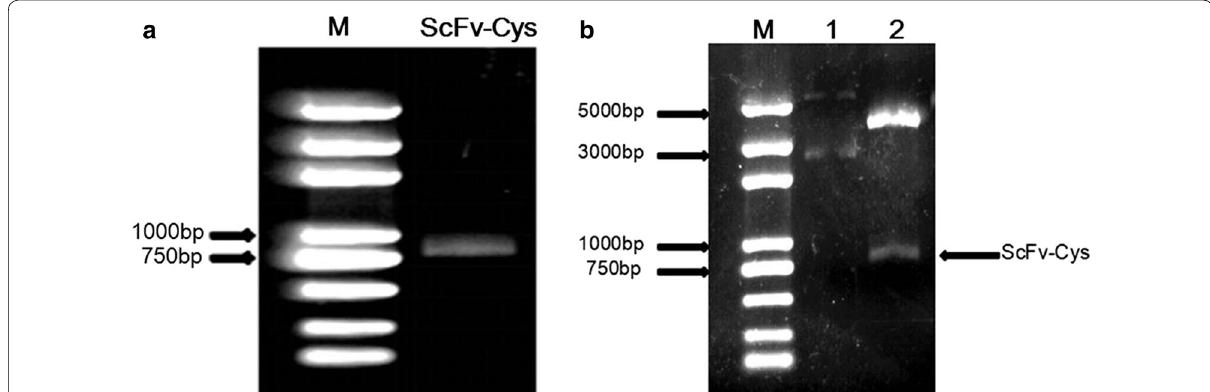
Fig. 1 Synthesis of ScFv-Cys and construction of recombinant plasmid. a The PCR product of ScFv-Cys. b Identification of the recombinant plasmid by enzyme digestion. Lane 1, the recombinant plasmid without enzyme digestion. Lane 2, the digested recombinant plasmid with Nde I and Xho I